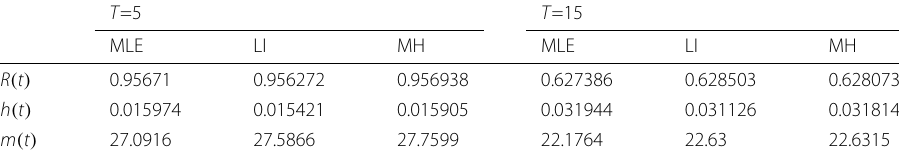
Table 9 Point estimates of R ( t ) , h ( t ) , and m ( t ) for different choices of T from data set